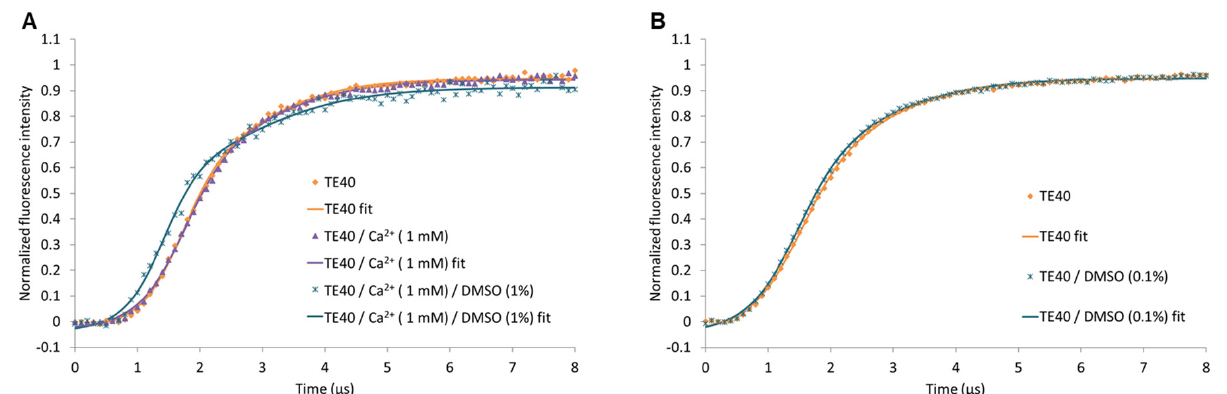
Figure 5. Influence of Ca 2+ and DMSO on the upward motion of the hTGase 2-dsDNA lever (non- directed labeling). ( A ) Time-dependent normalized fluorescence intensity in TE40 buffer with or without 1 mM CaCl 2 or with both 1 mM CaCl 2 and 1% DMSO are shown. ( B ) Effect of reducing the DMSO concentration to 0.1%. Curves with the best-fit parameters (referred to as “fit”) of a double logistic function are shown for each solvent composition.